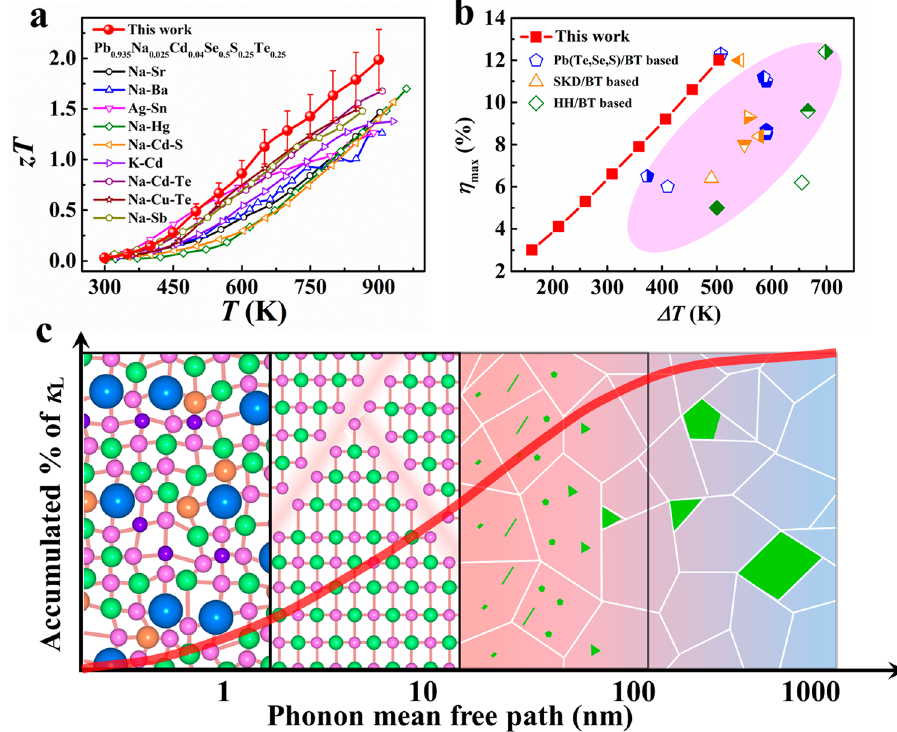
Fig. 1 Improving TE performance in all-scale hierarchical structures through entropy engineering. a Temperature dependence of zT values for p-type chalcogenides in this work. The results of p-type PbSe-based materials in the literature are also included 25 – 35 . b Temperature difference ( Δ T ) dependence of maximum conversion ef fi ciencies ( η max ) for chalcogenides-based segmented TE modules in this work. The results of Pb(Te,Se,S)/Bi 2 Te 3 - based 18,46,47,49 – 51 , Skutterudite/Bi 2 Te 3 -based 48,52 – 56 , and half-Heusler/Bi 2 Te 3 -based 57 – 59 TE modules in literature are also included (the pink area). c Phonon mean free path dependence of accumulated lattice thermal conductivity κ L (the red line) and schematic diagram of all-scale hierarchical structures (point defects, planar defects, nanoprecipitates, and mesoscopic precipitates). The pink, orange, green, blue, and purple spheres represent Pb, Na, Se, Te, and S atoms, respectively. The green and red grains represent CdS and high-entropy matrix,